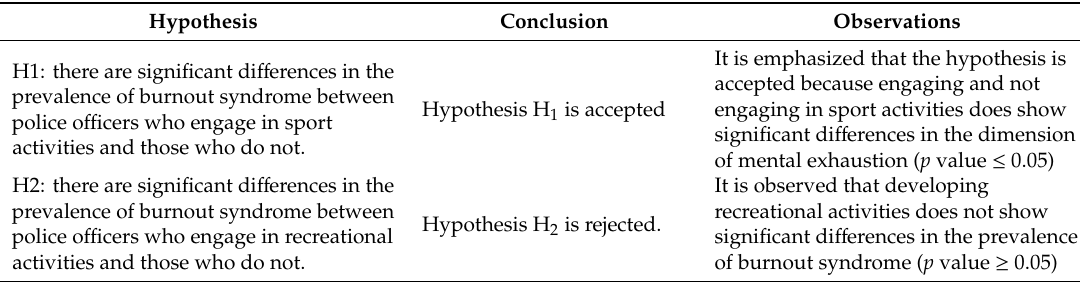
Table 5. Hypotheses